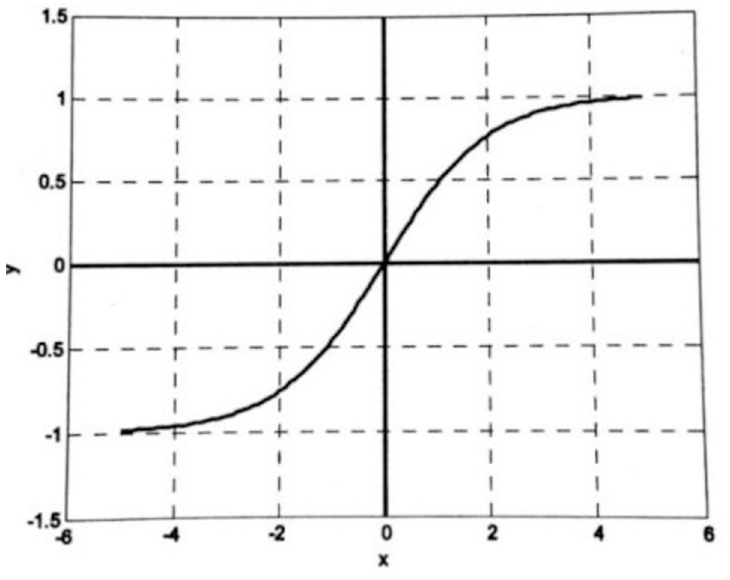
Fig 4. Tan-Sigmoid